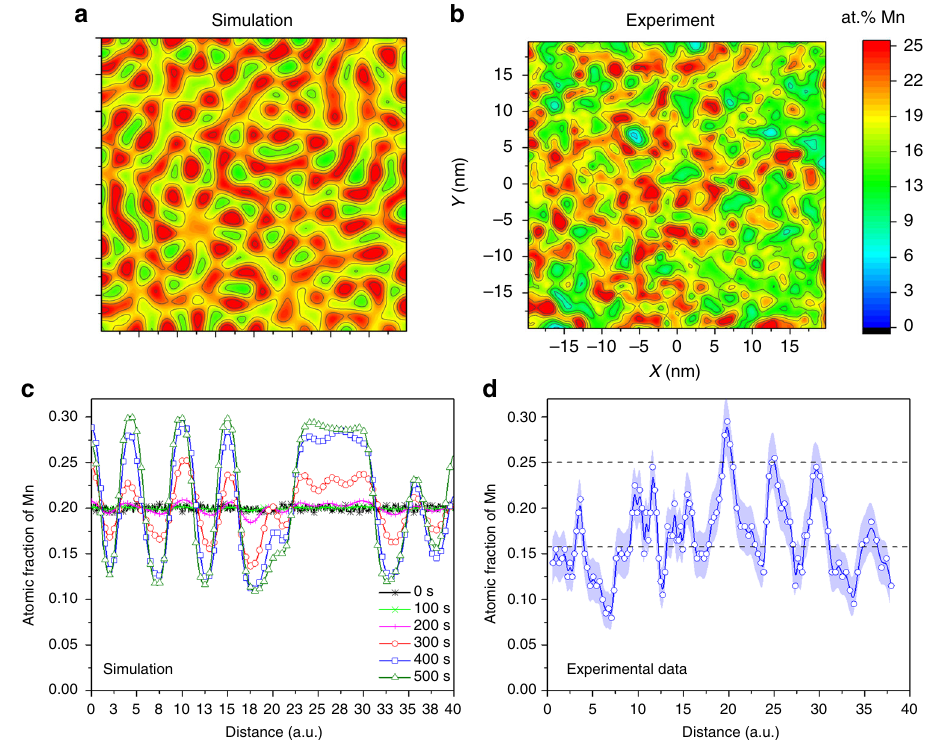
Fig. 5 Comparison between simulation and experiments. a , c 2D simulation of a spinodal decomposition using the continuous Cahn – Hilliard equation. b , d Experimental results (APT) for a grain boundary from Fe-9 atomic % Mn solid solution, 50% cold-rolled, and annealed at 450 °C for 6 h. The a , b maps have the same color bar. The map in a is a concentration map for 300 s of simulation time. The c , d concentration pro fi les were obtained from the cross- section of a and b , respectively. c composition pro fi les for different simulation times. The points in d are the experimental values, which are connected by blue lines. The blue shading represents the statistical error associated with the calculation of the composition. The black dashed lines show the values of the chemical